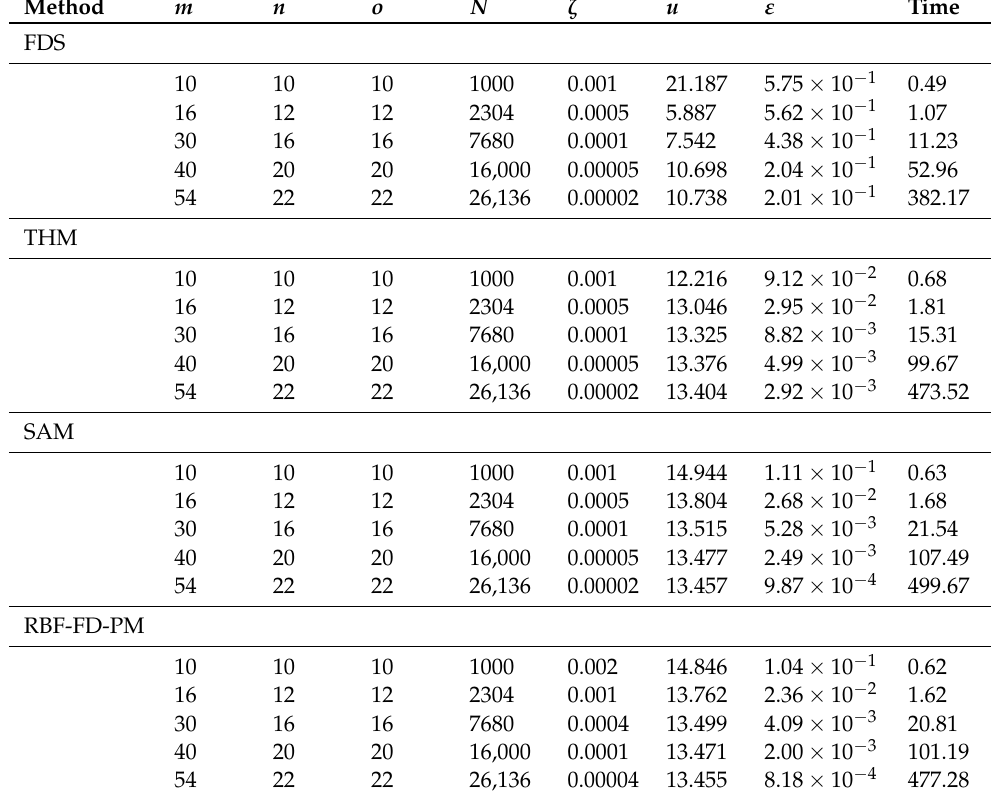
Table 2. Computational results for Case